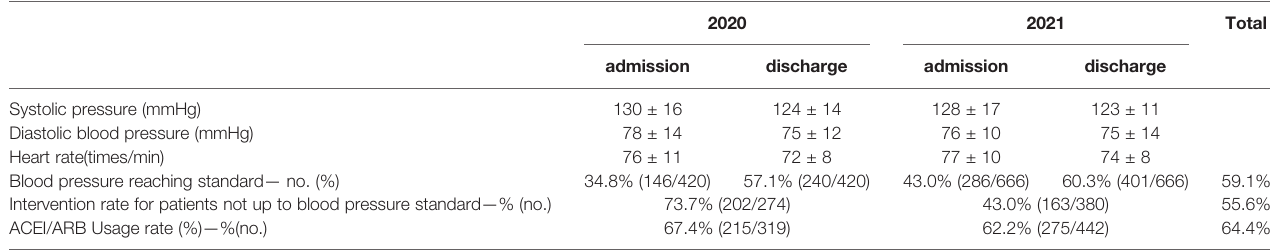
TABLE 5 | Blood pressure and medication of type 2 diabetes inpatients.